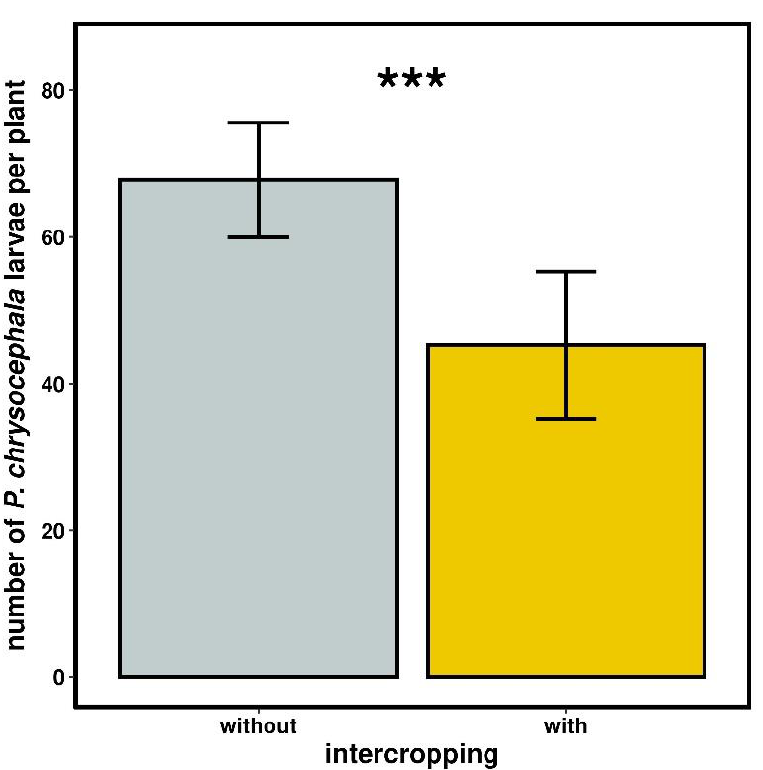
Figure 1. Intercropping Brassica napus reduces the number of Psylliodes chrysocephala larvae in plants when Vicia faba did not freeze over winter. Average number of P. chrysocephala per control (gray) and intercropped (yellow) B. napus . Bars represent SEM; *** indicates p -values < 0.001.